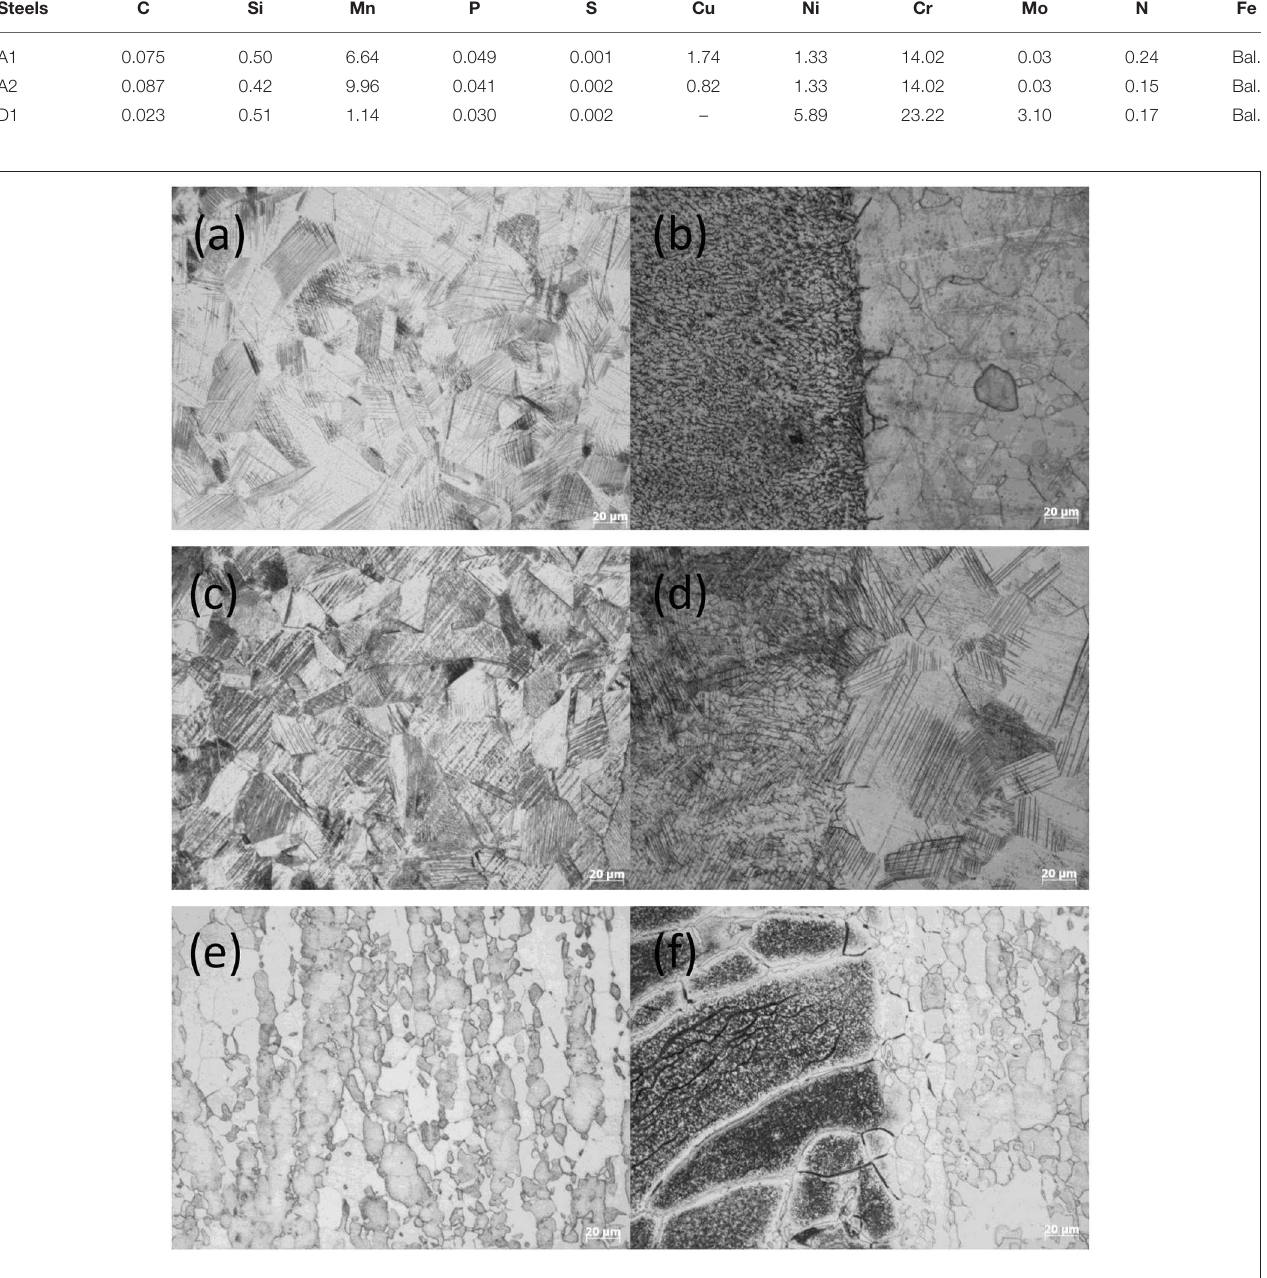
FIGURE 1 | Optical images of three stainless steels showing microstructures of base metal and weld seam: (a) A1 base metal, (b) A1 weld seam, (c) A2 base metal, (d) A2 weld seam, (e) D1 base metal, and (f) D1 weld seam.